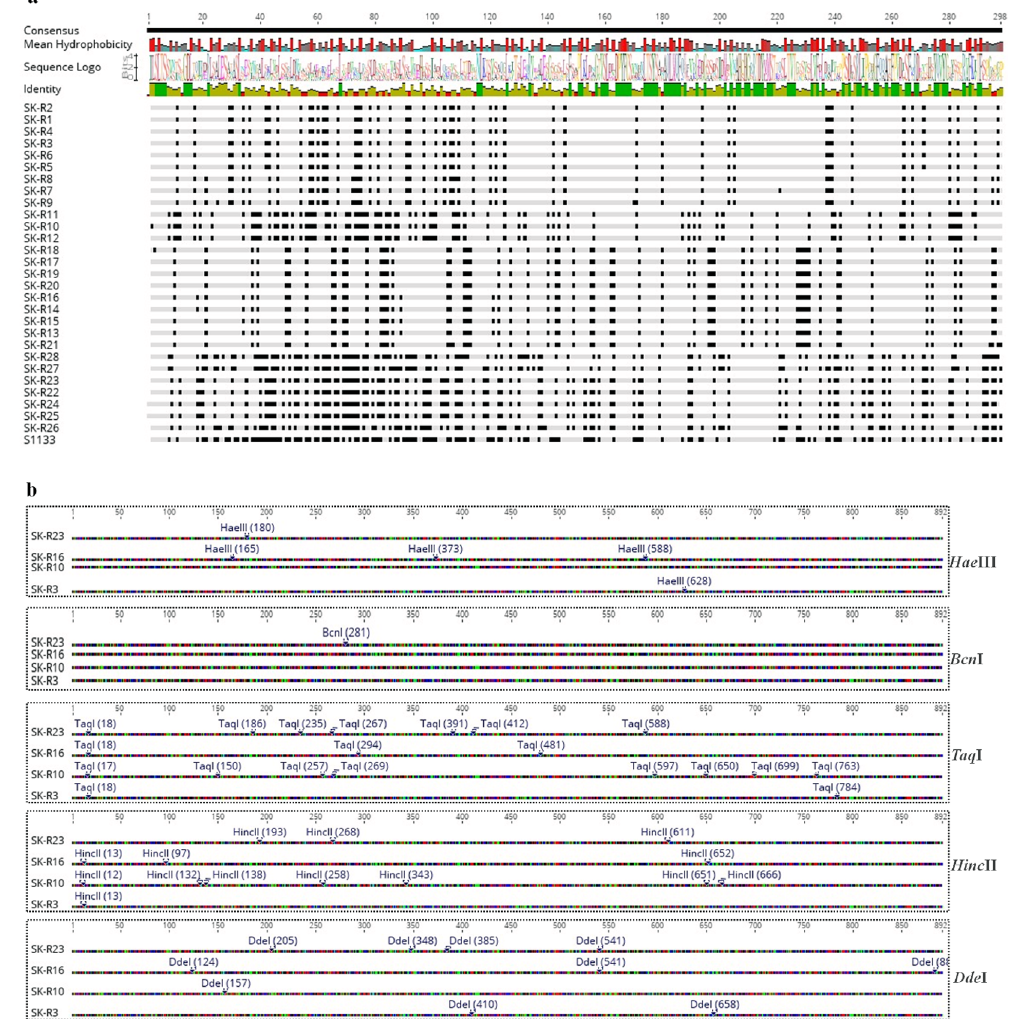
Figure 6. ( a ) A multiple amino acid sequence alignment of the common American vaccine strain S1133 and the 28 ARV field isolates. The alignment was made by a ClustalW alignment with BLOSUM cost matrix technique. Disagreements to the consensus sequence are highlighted. ( b ) Mapping of Dde I, Hinc II, Taq aI, Bcn I and Hae III restriction sites on Sigma C sequences of the ARV isolates (i.e. one isolate from each cluster group SK-R23 [Cluster II], SK-R16 [Cluster IV], SK-R10 [Cluster V], SK-R3 [Cluster